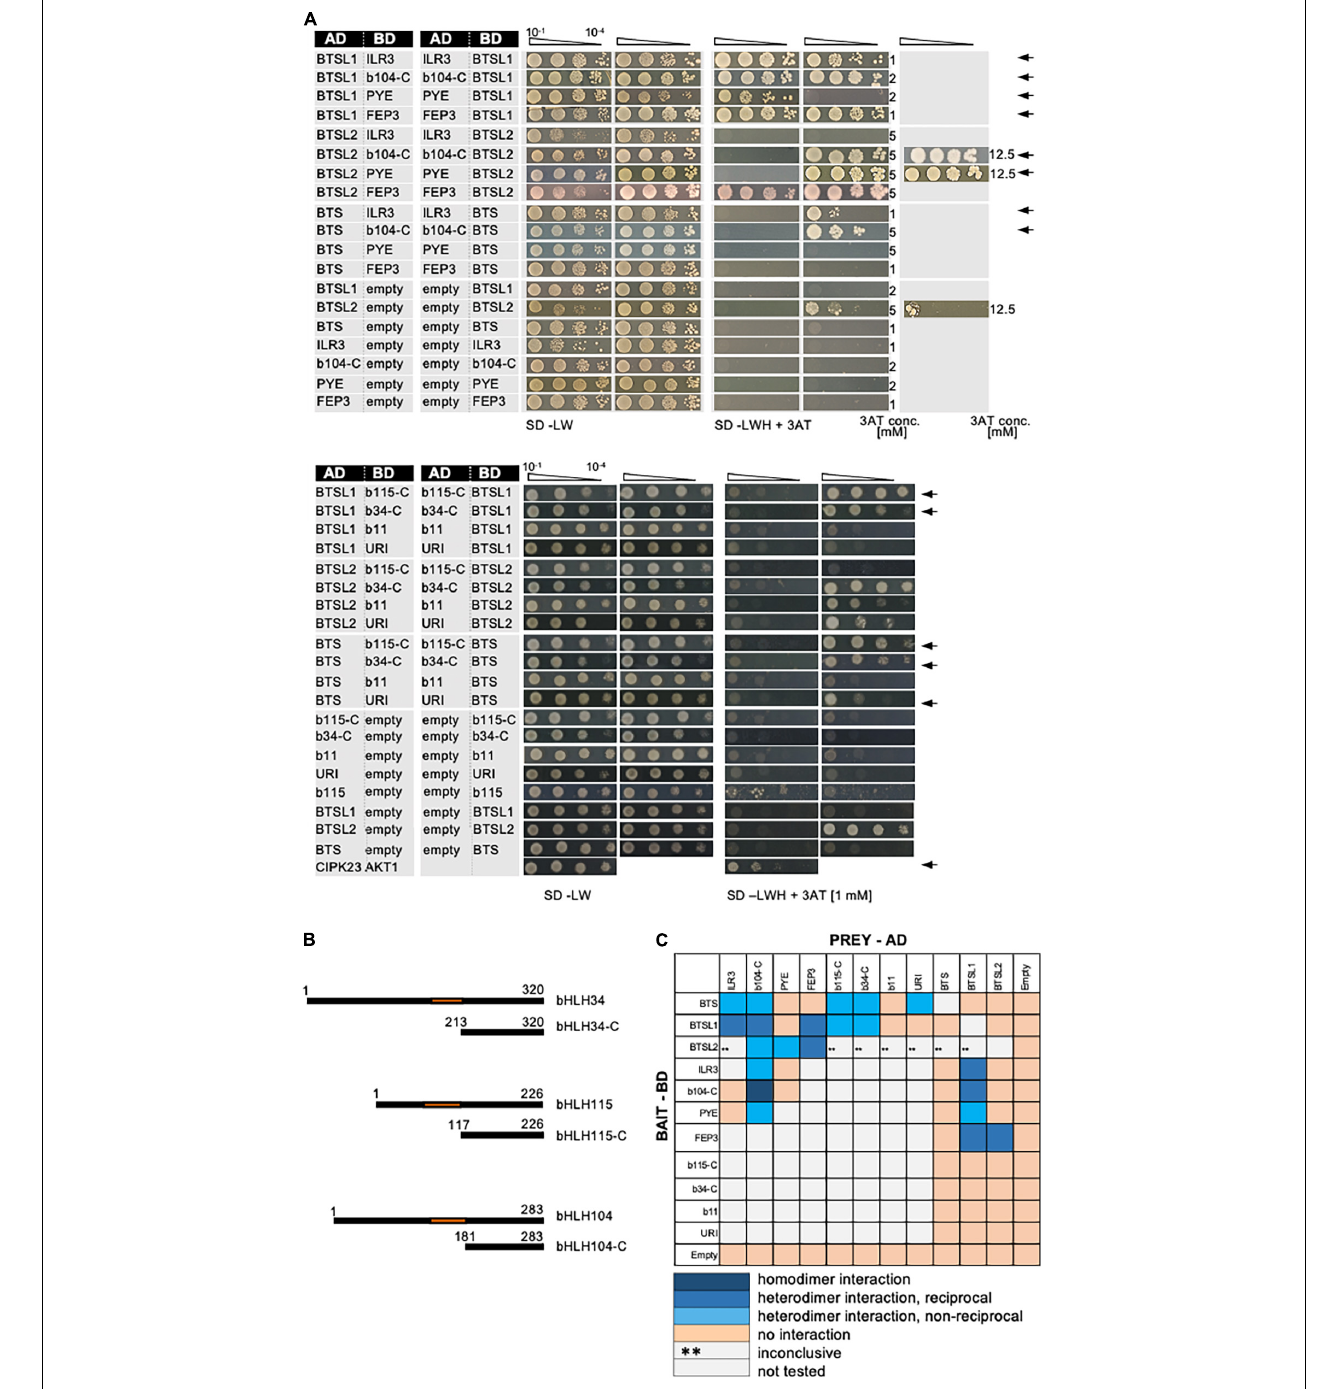
FIGURE 2 | Validation of the BTS/L-bHLH-FEP3/IMA1 interactome. (A) BTSL1 and BTSL2 were tested in reciprocal targeted Y2H assays against various bHLH proteins of the subgroups IVb and IVc and FEP3. Yeast co-transformed with the AD and BD combinations were spotted in 10-fold dilution series (A 600 = 10 − 1 –10 − 4 ) on SD-LW (transformation control) and SD-LWH plates supplemented with different concentrations (conc.) of 3AT as indicated on the right side (selection for protein interaction). Negative controls: empty vectors. Positive control: CIPK23 and AKT1. Arrows indicate interaction. (B) Schematic representation of full-length bHLH34, bHLH115, bHLH104 and their respective C-terminal parts used for Y2H. C-terminal parts lack the N-terminus and the DNA-binding domains (represented in orange). (C) Summary results of A. The color code distinguishes homodimeric interaction (dark blue), reciprocal heterodimeric interaction (middle blue), non-reciprocal heterodimeric interaction (light blue), no interaction (light orange) or inconclusive and non-tested interactions ( ∗∗ , light gray). Additional controls and Y2H validation data are presented in Supplementary Figure 3 .